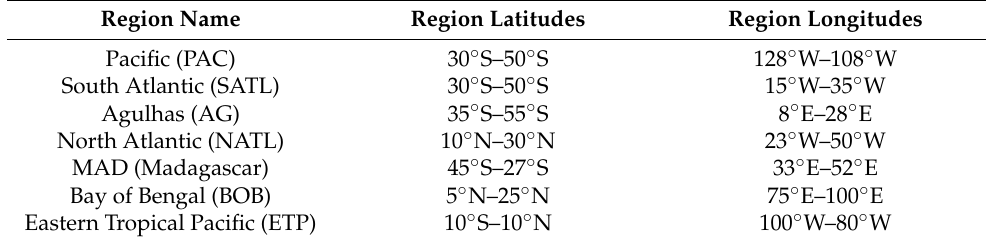
Table 1. Latitude and longitude ranges of the seven regions